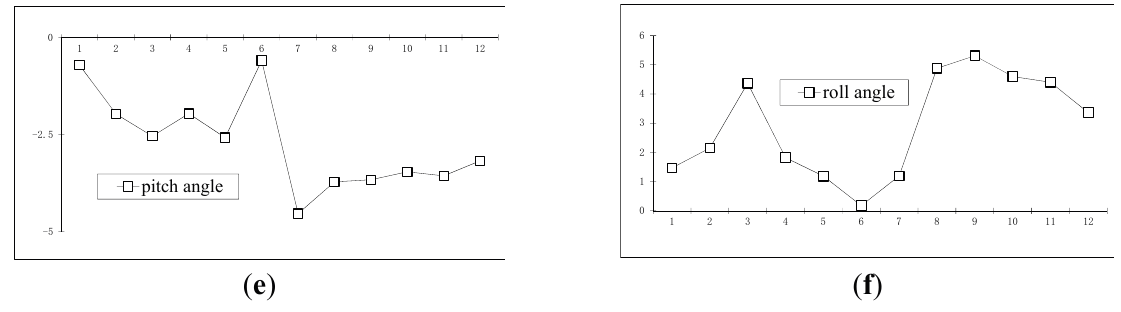
Figure 14. The recovery of the doll. ( a ) The points to be measured on the doll; ( b ) The trajectory reconstruction results of three moving points on the doll in the XY plane; ( c ) Those in the Z direction; ( d ) The measurement results of the pitch angle of the doll; ( e ) The measurement results of the yaw angle of the doll; ( f ) The measurement results of the roll angle of the